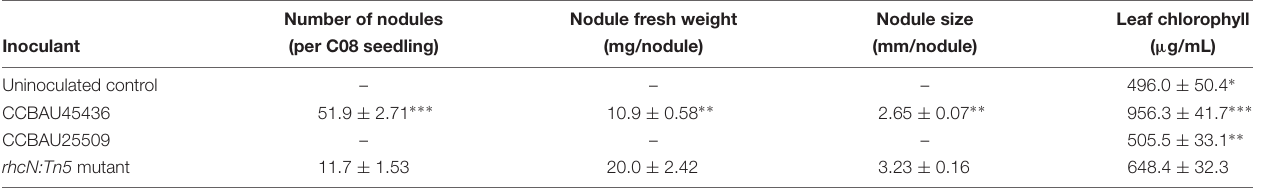
TABLE 2 | Performance of soybean accession C08 carrying the Rfg1 allele when inoculated with CCBAU25509, the rhcN:Tn5 mutant of CCBAU25509, or CCBAU45436 28 days post-inoculation. Number of